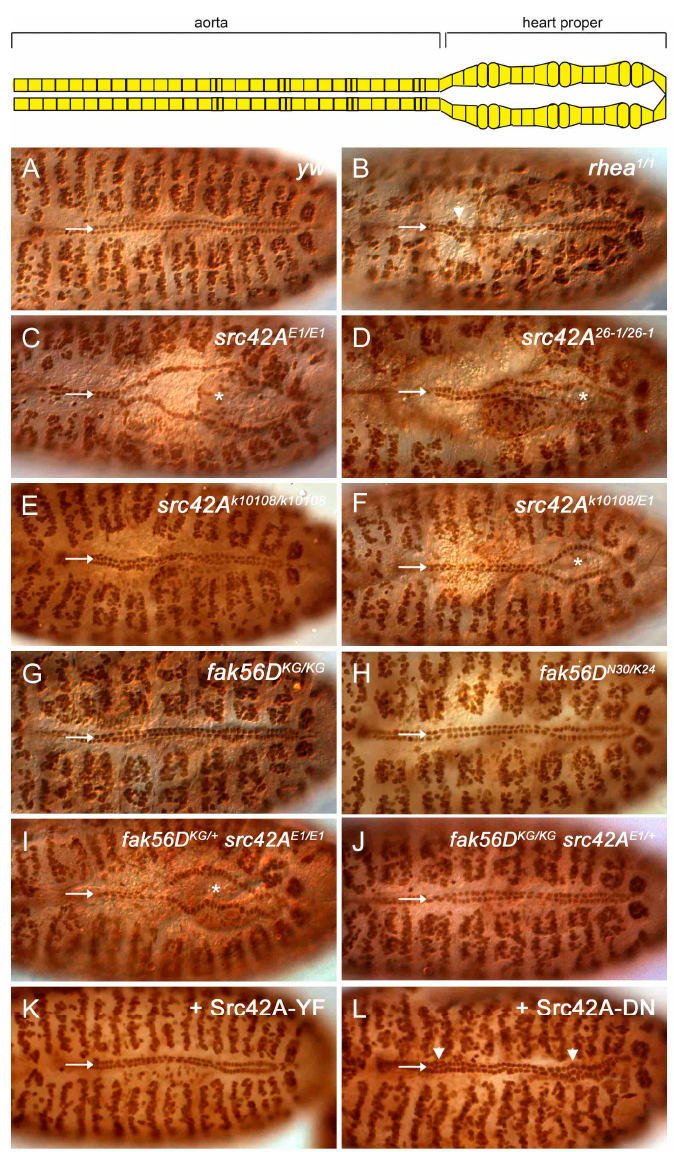
Figure 2. Loss of Src42A results in incomplete cardioblast migration. ( A ) By stage 17, the two CB rows are aligned along the dorsal midline in wildtype embryos. The two rows are close, but a narrow gap remains at the midline where the tube lumen is positioned (arrow). ( B ) In mutants of rhea , the gene encoding the Integrin-adaptor protein Talin, migration completes. However, occasional cell clumping occurs (arrowhead) and the space between the CBs rows is absent (arrow; [29]). ( C–F ) In src42A E1 and src42A 26-1 null mutants, the posterior CBs fail to migrate to the midline (arrow) and the embryos exhibit an “open heart” phenotype (asterisks mark the open heart). The CBs in the src42A k10108 hypomorph migrate fully to the midline (E), although an open heart phenotype is observed in some src42A E1 / src42A k10108 mutants (F, asterisks). ( G–J ) Similar to wildtype embryos (A), fak56D mutant embryos have normal CB alignment and migration (G, H). Reducing the gene copy of fak56D did not enhance the delay in CB migration in src42A E1 mutant embryos (I) Reducing the gene copy of src42A did not induce a heart phenotype in fak56D mutant embryos (J). ( K ) Constitutively active Src42A was overexpressed in the heart and somatic muscles. Similar to wildtype, the heart cells were aligned, migrated to the midline, and maintained a narrow gap between the two rows. ( L ) Expression of a dominant negative form of Src42A kinase did not prevent CB migration. However, cells were frequently misplaced relative to neighboring cells, resulting in cell clumps (arrowhead). Posterior of the heart is to the right in all